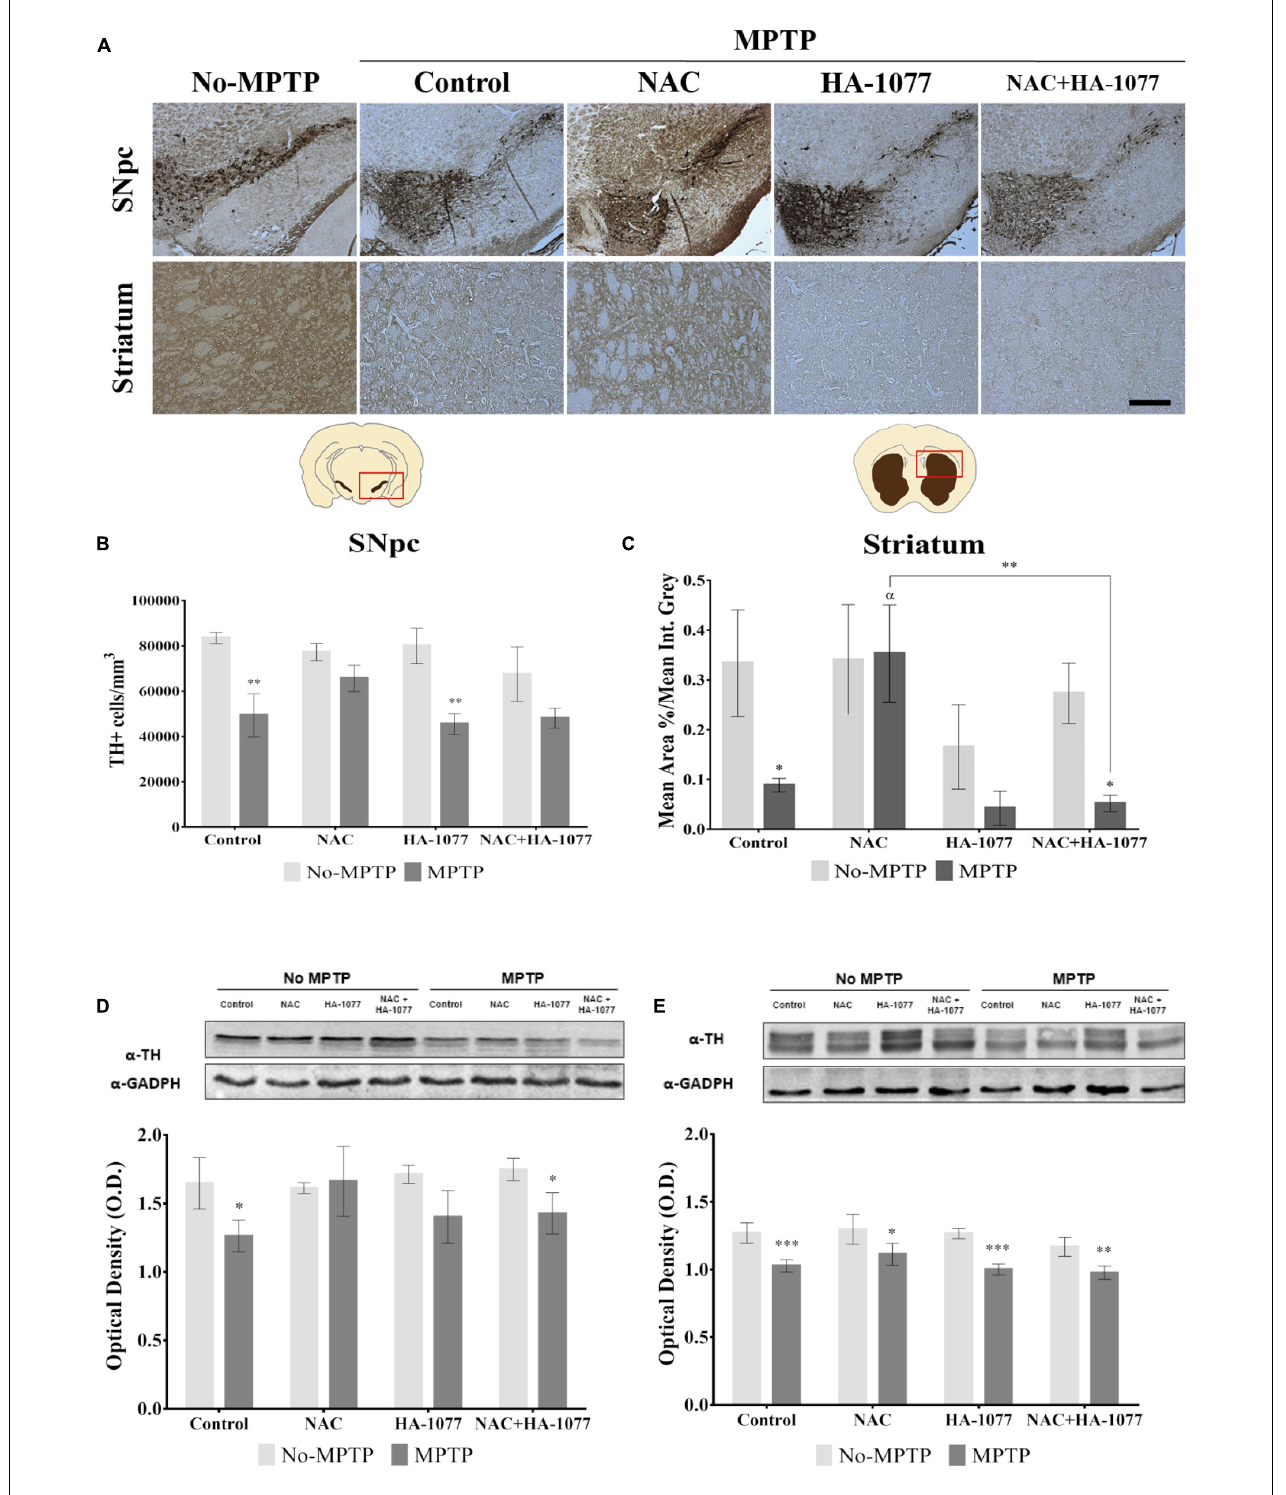
FIGURE 2 | Effect of the different treatments (NAC, HA-1077 and NAC+HA-1077) on dopaminergic neuronal death. (A) Representative micrographs of TH immunostaining in coronal sections at the SNpc and striatum levels: No-MPTP, MPTP, MPTP+NAC, MPTP+HA-1077, MPTP+NAC+HA-1077 (Magnification 10 × , Scale bar = 100 µ m). (B,D) Quantification of TH expression in SNpc by immunohistochemical analysis. (B) Very significant increase in dopaminergic neuronal death